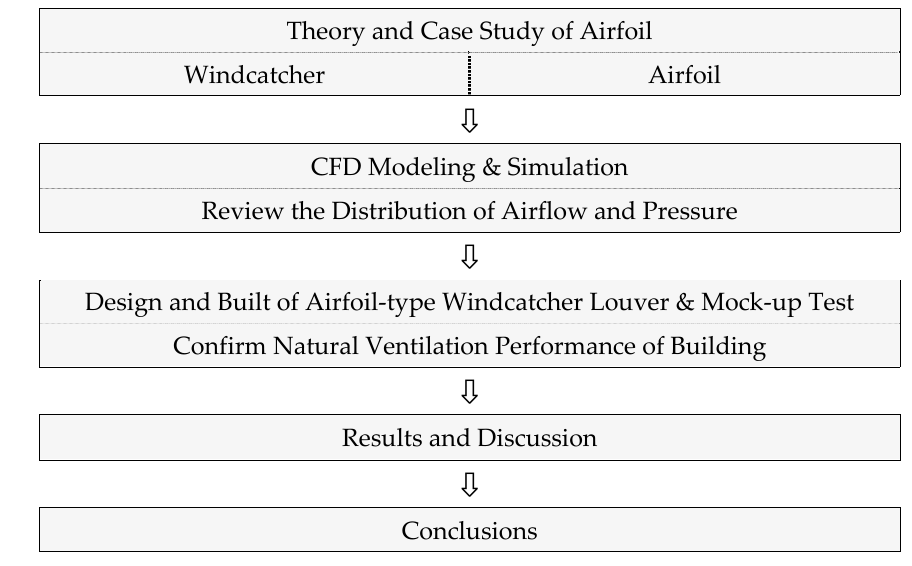
Figure 1. Flow chart of the structure of the remainder of the paper.